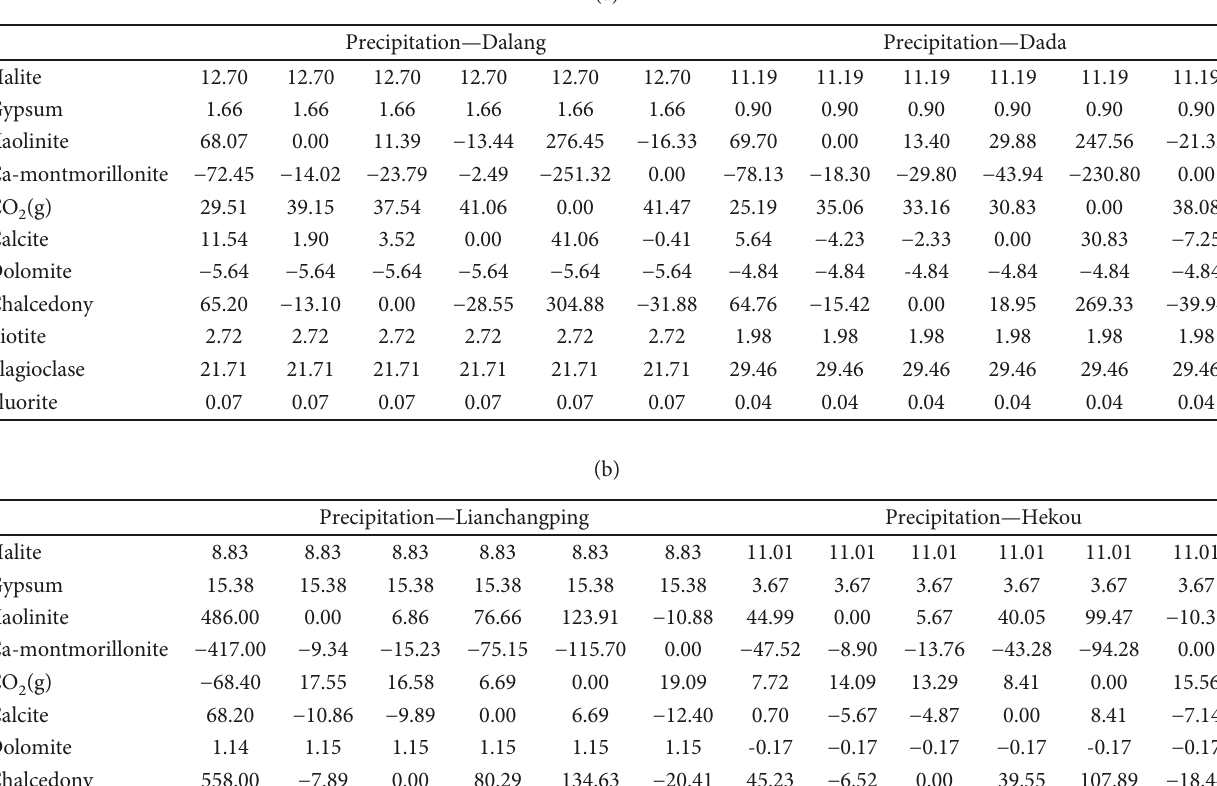
Table 6: Reactant compositions and mole transfers simulated by PHREEQC. Mole transfer in millimoles per kilogram water (mmol/kg), positive values indicating dissolution, and negative values indicating precipitation. (a) Precipitation — Dalang Precipitation — Dada